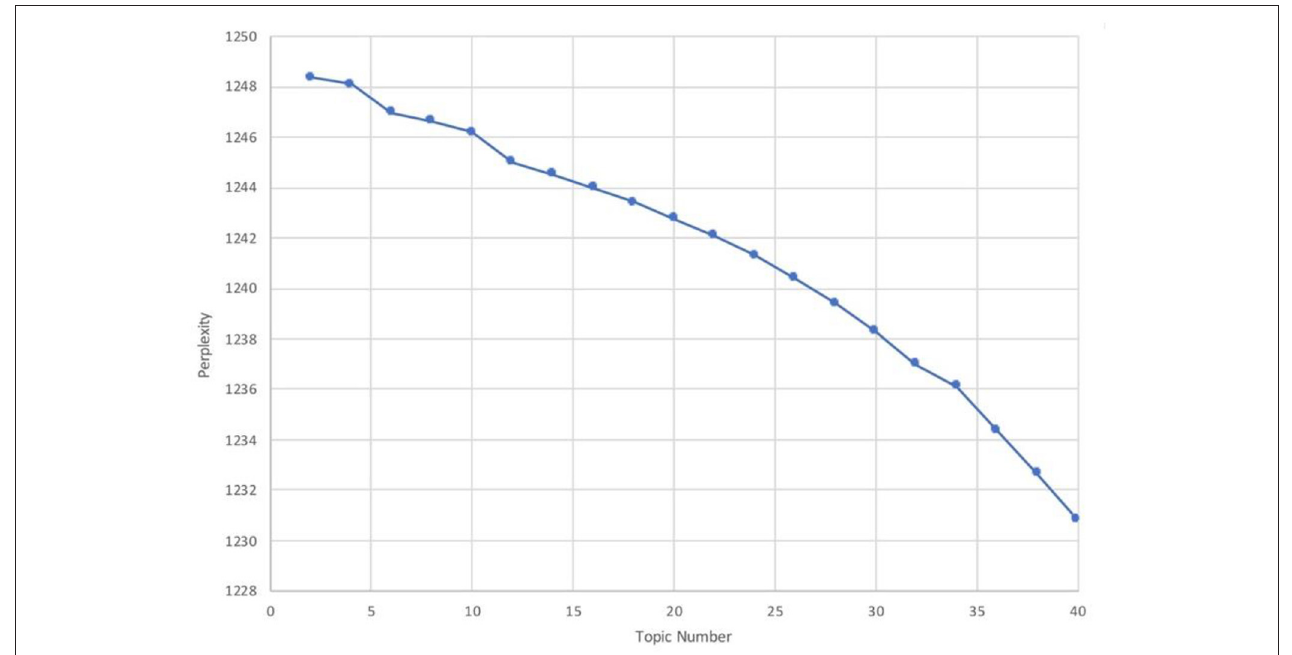
FIGURE 9 | Perplexity scores of different topic solutions. Source: created by the authors.